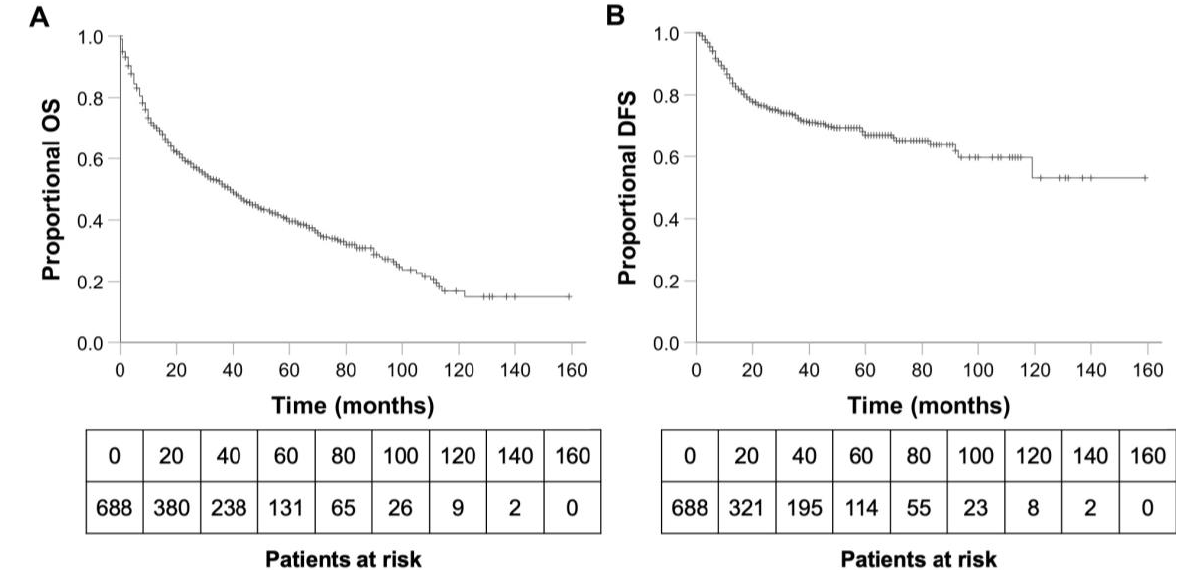
Figure 1. ( A ). Overall survival of the 688 patients ≥ 70 years with HNSCC. ( B ). Disease-free survival of the 688 patients ≥ 70 years with HNSCC. OS, overall survival; DFS, disease-free survival. Table 2. Cross-table relating the UICC stage to the causes of death.